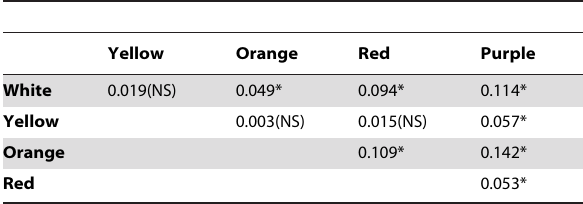
Table 3. Fixation indexes ( F CT ) among colour groups based on microsatellite